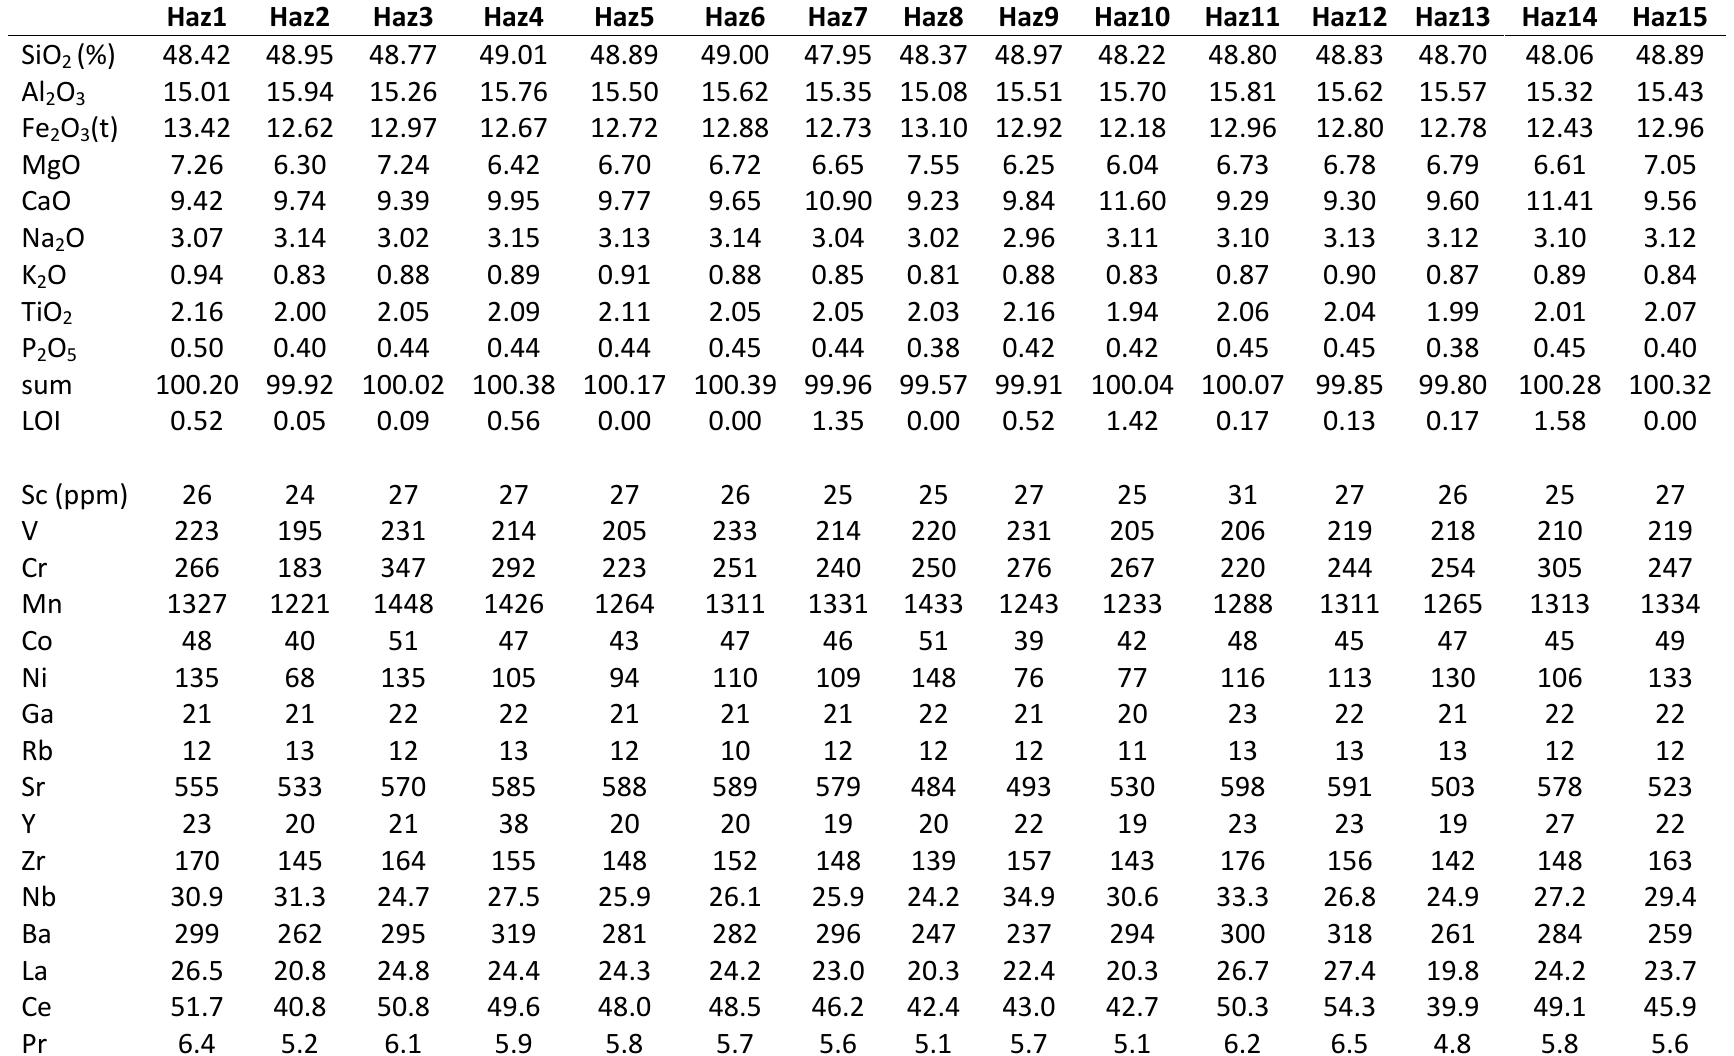
Table 2. Major and trace element composition of the Tel Hazor basalt vessels. Abbreviations: RMS - root mean